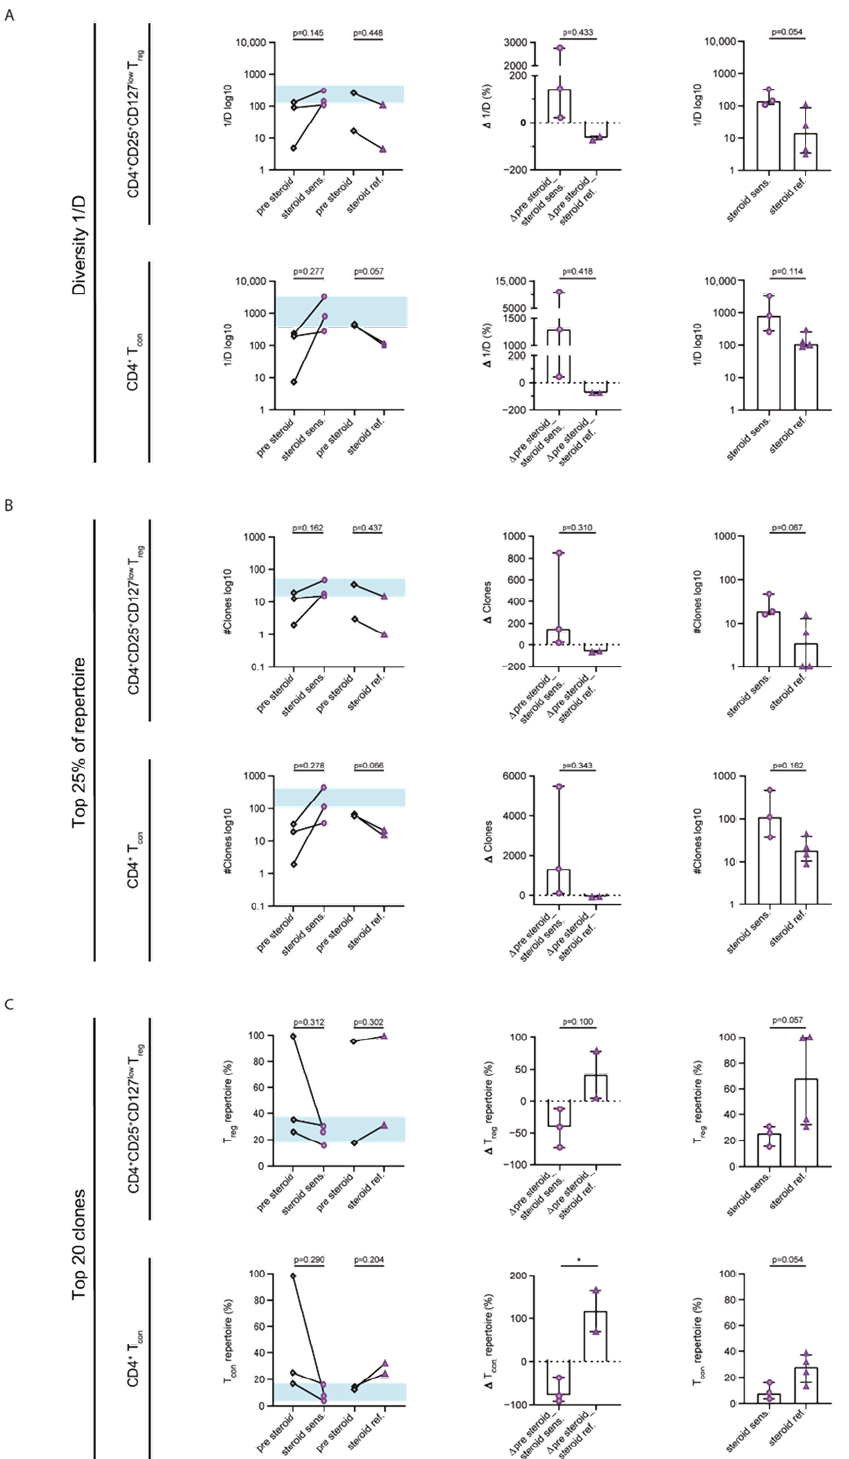
Figure 5. Steroid sensitivity is linked to diversification of the CD4 + CD25 + CD127 low T reg and Figure 5 CD4 + T con repertoires. ( A ) Comparison of CD4 + CD25 + CD127 low T reg (upper line) and CD4 + T con (bottom line) repertoire diversity assessed via the inverse Simpson index (1/D) in patients with GVHD receiving treatment with systemic steroids. Higher values of the inverse Simpson index indicated a more diverse repertoire. The left panel compares the last time point prior to steroid treatment (pre steroid; gray rhombs) and the first sample of steroid treatment, separated by means of steroid response in steroid sensitive (violet circles; n = 3) and steroid refractory (violet triangles; n =